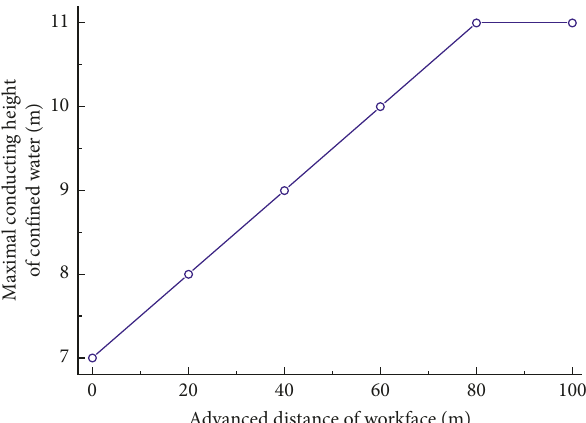
Figure 7: Maximal conducting height of confined water of workface floor along the inclined direction of coal seam with the advancement of workface (no water inrush).